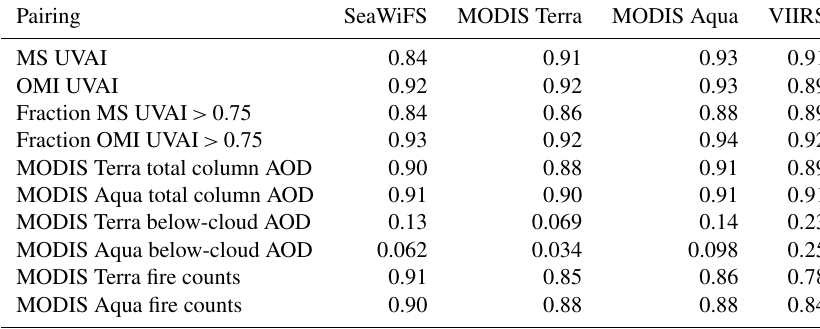
Table 4. Correlation coefficients between monthly mean AAC 550nm AOD and other time series shown in Fig. 13. Pairing